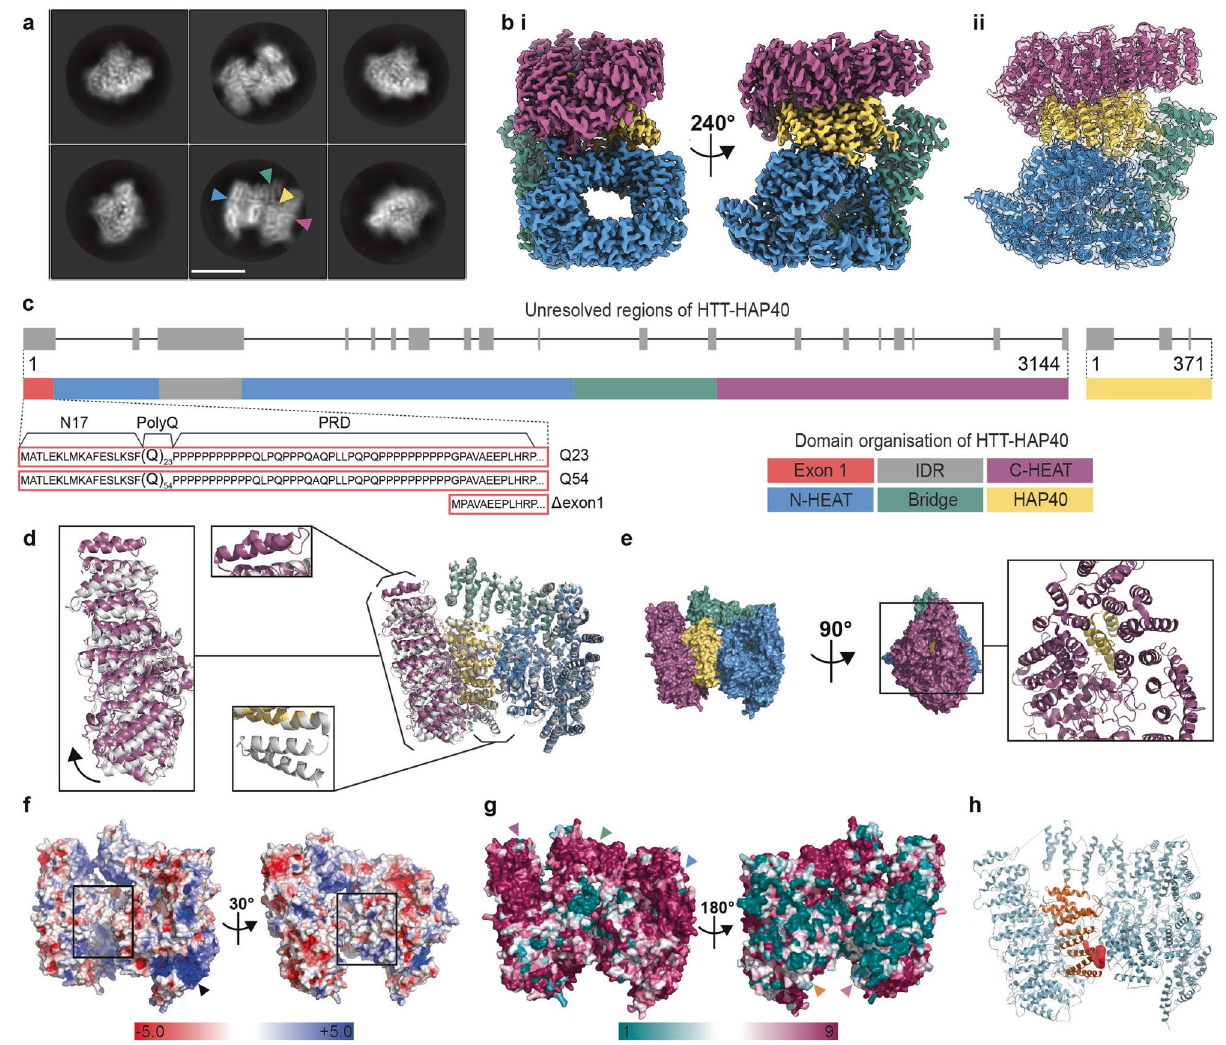
Fig. 2 HAP40 stabilises the structure of HTT via extensive interactions across all subdomains. a Representative cryo-EM 2D class averages of HTT- HAP40. Scale bar (white) is 90 Å. Blue and purple arrowheads denote N- and C-HEAT domains of HTT, respectively. Green and yellow arrowheads denote bridge domain of HTT and HAP40, respectively. b Cryo-EM volume of HTT-HAP40 resolved to 2.6 Å with (i) HTT N-HEAT in blue, bridge domain in green, C-HEAT in purple and HAP40 in yellow or (ii) map shown with HTT-HAP40 modelled in using the same domain colour convention. c Domain organisation of HTT shown mapped to linear sequence. Unresolved regions of the structure are in grey and the three different constructs used in this study are detailed comprising wild-type (23 glutamines; Q23), mutant (54 glutamines; Q54), or HTT with exon 1 partially deleted ( Δ exon 1; comprising residues 80 – 3144). d Superposition of our model (PDBID: 6X9O — same domain colour convention as before) and the previous model (PDBID: 6EZ8 — all grey) with alignment calculated over N-HEAT and bridge domains. Additional α -helices observed in either of the models are indicated with boxes, C-HEAT domain shift is shown with an arrow. e Surface representation of HTT and HAP40 (same domain colour convention as before) in front and side views, rotated 90°, with additional panel (right) showing same side view of the complex in cartoon format. f Electrostatic surface representation of HTT with HAP40 removed from the structure. Positively charged regions are shown in blue, neutral regions in white and negatively charged regions in red. The positively charged tract in the N-HEAT domain is indicated with a black arrowhead. Hydrophobic HTT surface that binds HAP40 is indicated with hollow black boxes. g Surface representation of HTT-HAP40 complex, coloured according to Consurf conservation scores: from teal for the least conserved residues (1), to maroon for the most conserved residues (9). Conserved surfaces for C-HEAT, bridge and N-HEAT domains are indicated with purple, green and blue arrowheads, respectively. Variable N-HEAT and C-HEAT surfaces are indicated with orange and pink arrowheads, respectively. h HTT (pale blue)-HAP40 (orange) complex in cartoon with pocket predicted to be druggable shown as red